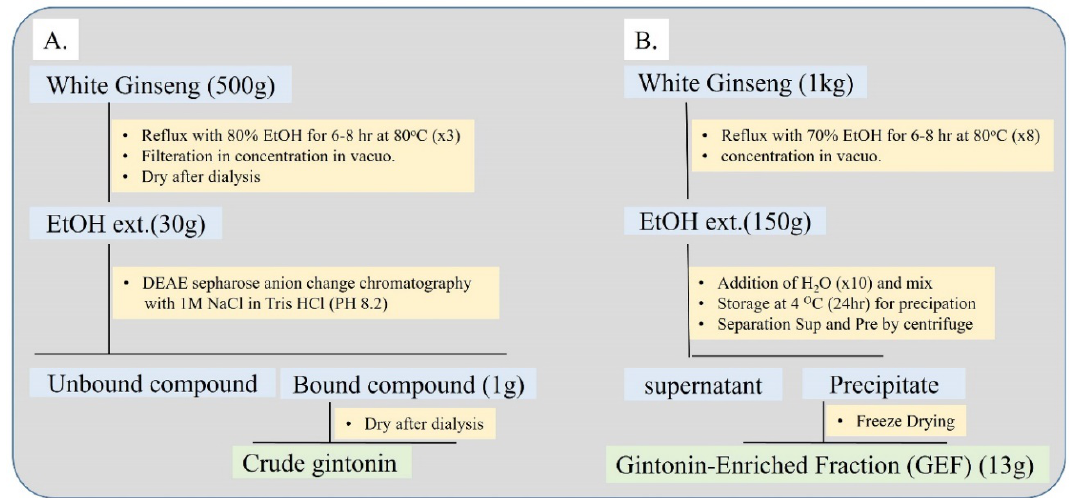
Figure 2. Methods for the preparation of gintonin-enriched fraction (GEF) from ginseng. ( A ) A method for gintonin fraction preparation using ethanol extraction and diethylaminoethyl (DEAE) anion exchange chromatography. Gintonin fraction was prepared from eluate of anion exchange chromatography. ( B ) A simple method for GEF using only ethanol and water. Ethanol extract is dissolved in water, leading to the formation of a precipitate, and centrifuge is used to separate the supernatant and precipitate. The precipitate from water fractionation is designated GEF with a yield of 1.3%.